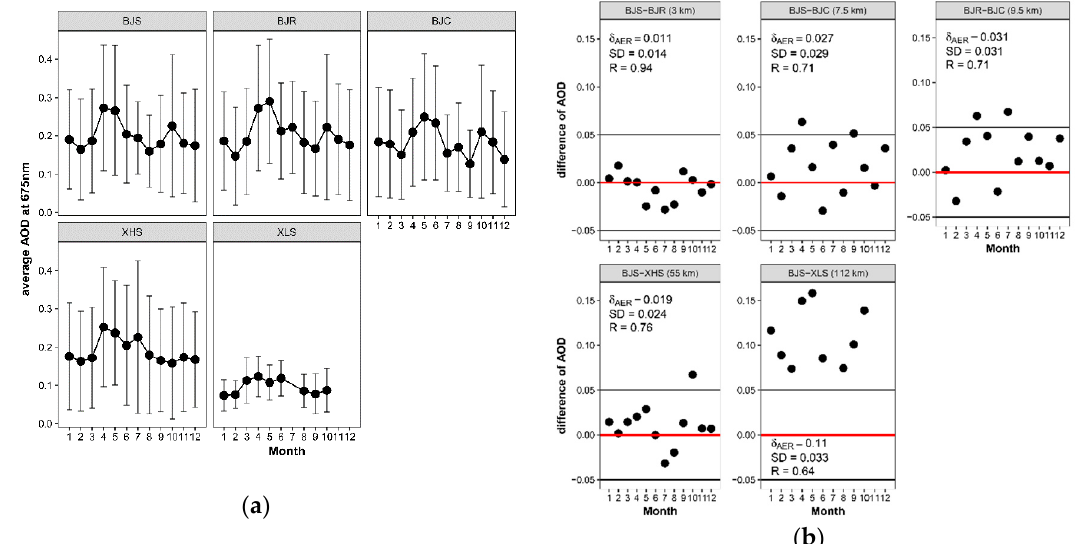
Figure 2. Overview of the monthly statistics of AOD at 675 nm (AOD 675 ) at five AERONET stations. ( a ) The monthly averaged AOD 675 (vertical lines indicate the standard deviations), and ( b ) the difference in AOD 675 between two sites. The δ AER defined as | site 1 − site 2 |